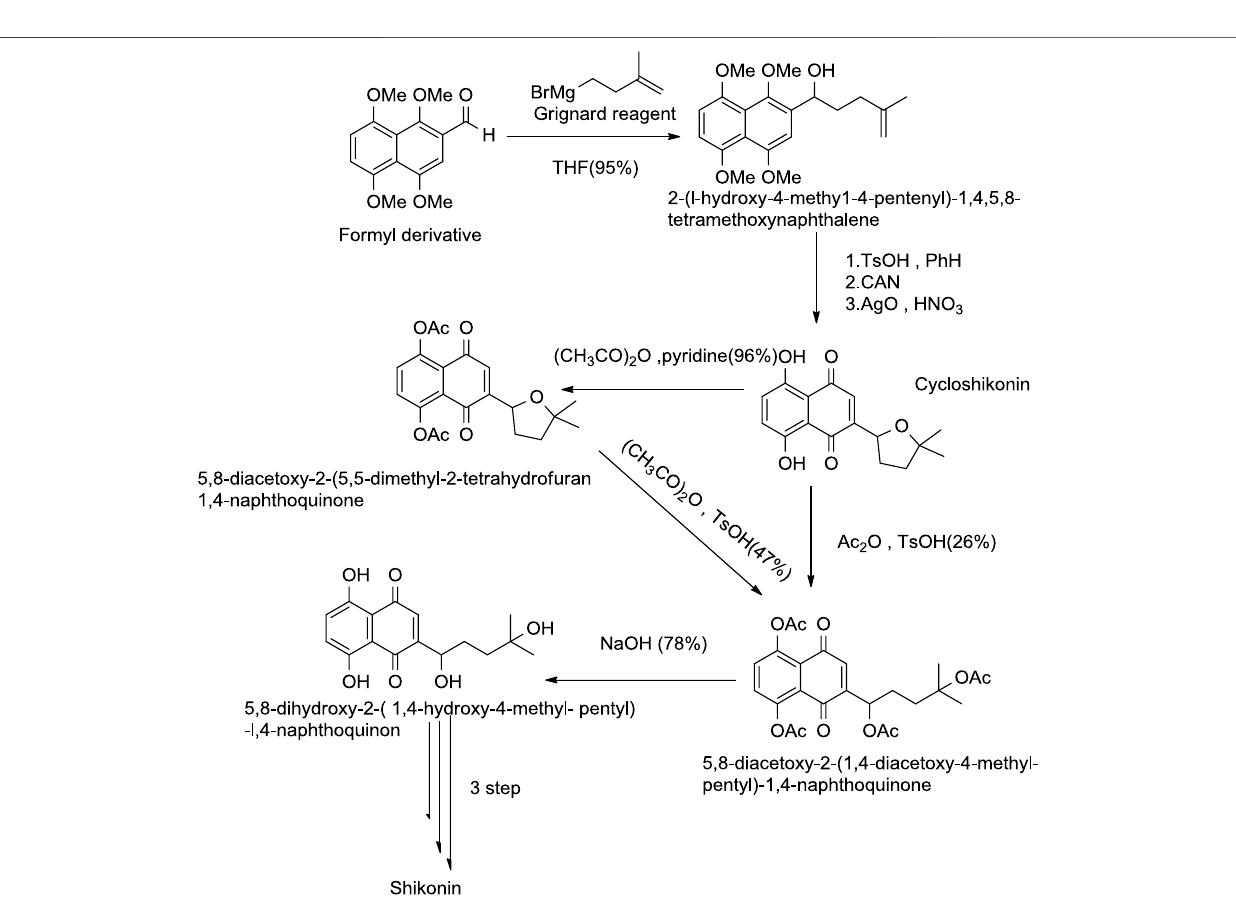
Frontiers in Pharmacology |